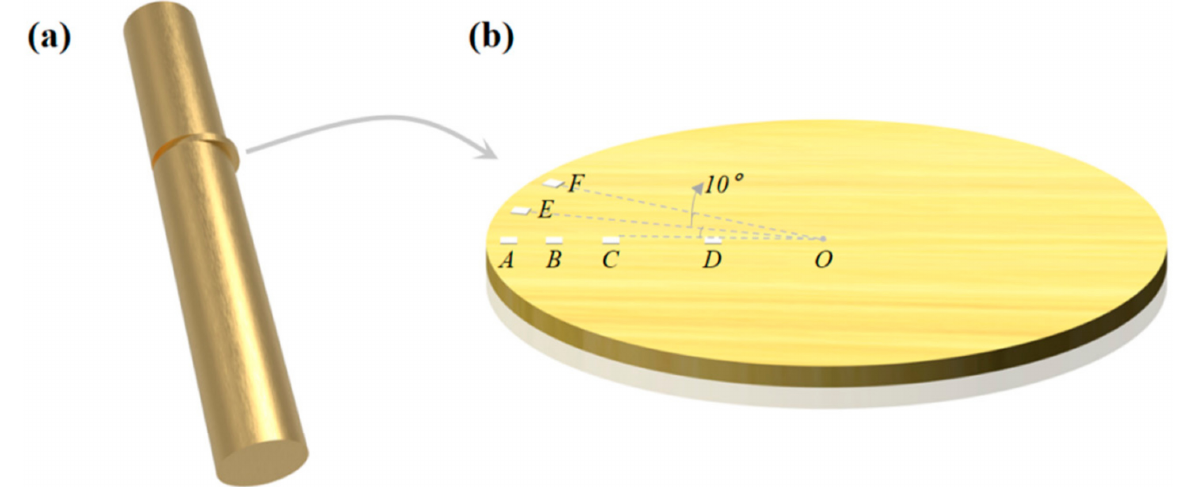
Figure 3. Schematic illustration of the electron backscatter diffraction (EBSD) investigated locations. ( a ) The EBSD samples were cut from the processed specimen perpendicularly to the central axis, ( b ) A–F shows the position for EBSD, where B, C, D are 1 mm, 2 mm, and 4 mm away from the edge, A, E, F are 250 µ m away from the